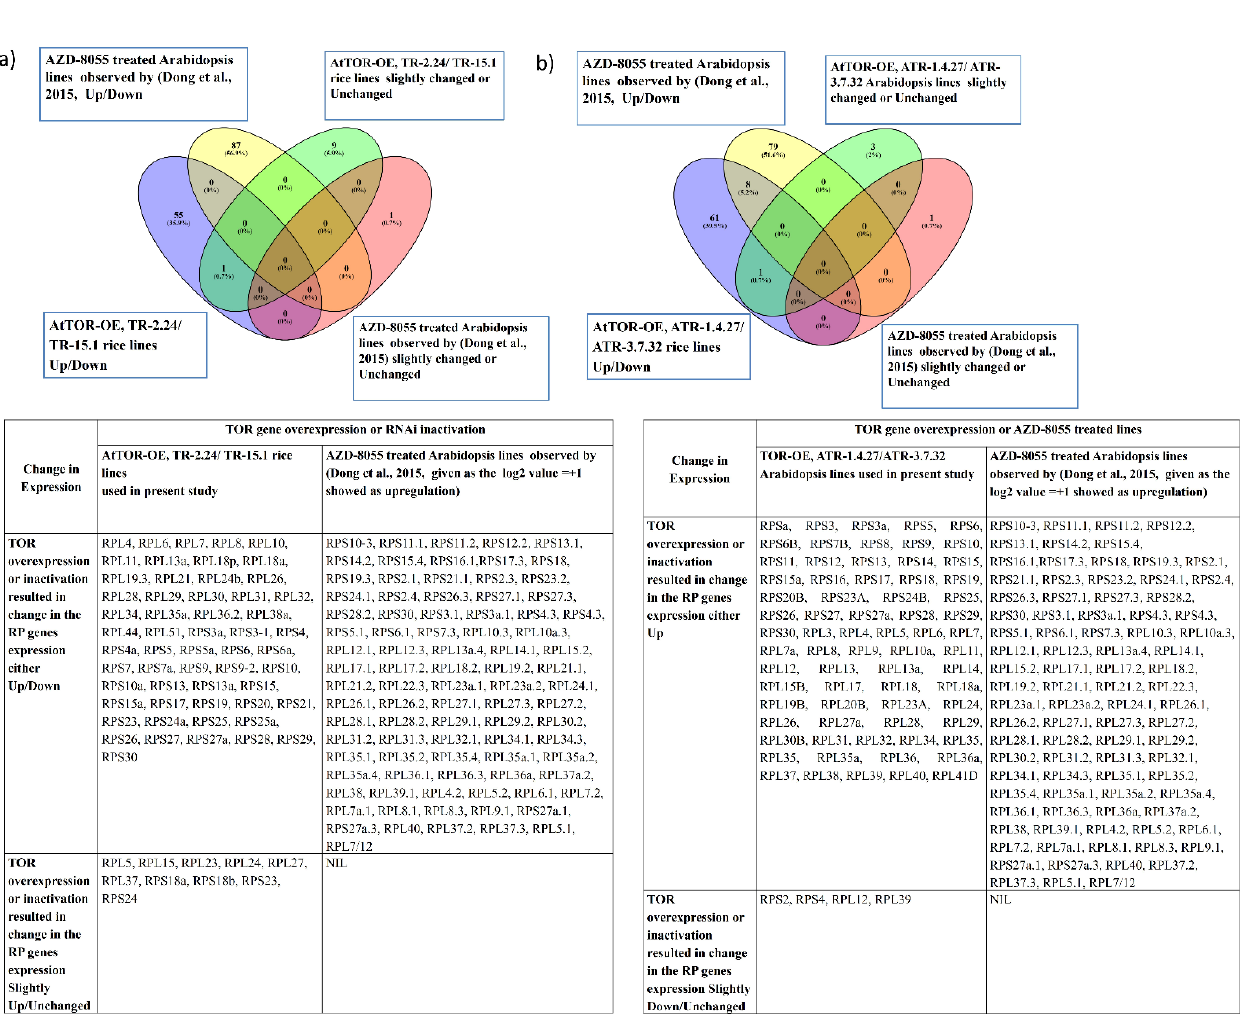
Figure 3. Comparison of the overlapping expression patterns of RPL and RPS genes in TOR -OE lines of rice and Arabidopsis with the AZD-8055-treated Arabidopsis lines. The RP genes exhibiting a transcript level of ≥ 1-fold on log 2 scale were considered as significantly upregulated and the transcript level below 1-fold was considered downregulated or unchanged in expression. Venn diagrams are used to show the overlaps between the RP gene expression ( a ) in the AZD-8055-treated lines of Arabidopsis (Dong et al., 2015 [27]) and TOR -OE lines of rice (TR-2.24 and TR-15.1) and ( b ) in the AZD-8055-treated lines of Arabidopsis and TOR -OE Arabidopsis lines, ATR-1.4.27 and ATR-3.7.32. Among the analyzed RP genes in rice (71 RP genes) and in Arabidopsis (73 RP genes), AtTOR -OE lines TR-2.24, TR-15.1, ATR-1.4.27 and ATR-3.7.32, the transcript levels of